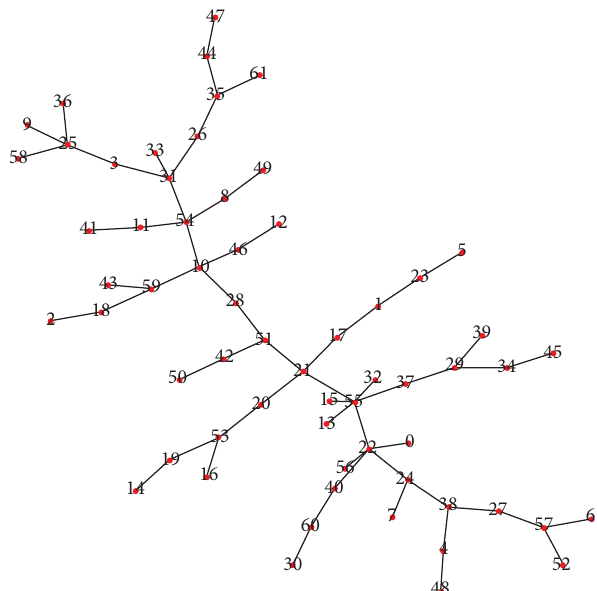
Figure 3: Energy stock jump complex network from October 2016 to April